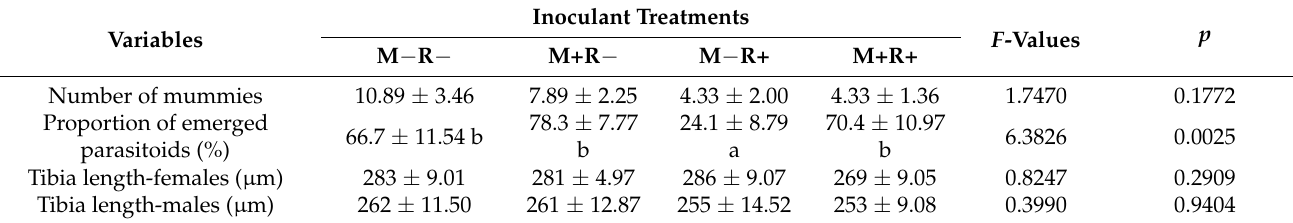
Table 1. Average of parasitoid wasp parameters measured as variables (mean ± SE, F, df = 3, p ) of 9 replicates per inoculant treatment (N = 9). Control: M − R − ; Mycorrhizae+Rhizobium: M+R+; Mycorrhizae: M+R − ; Rhizobium: M − R+. Linear mixed effect model (LMM) follows by ANOVA.